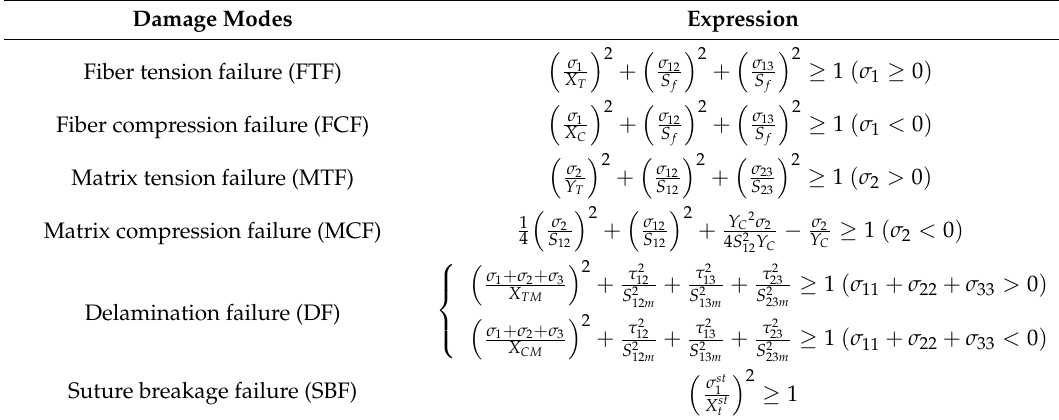
Table 1. Expression of six damage modes for low-velocity